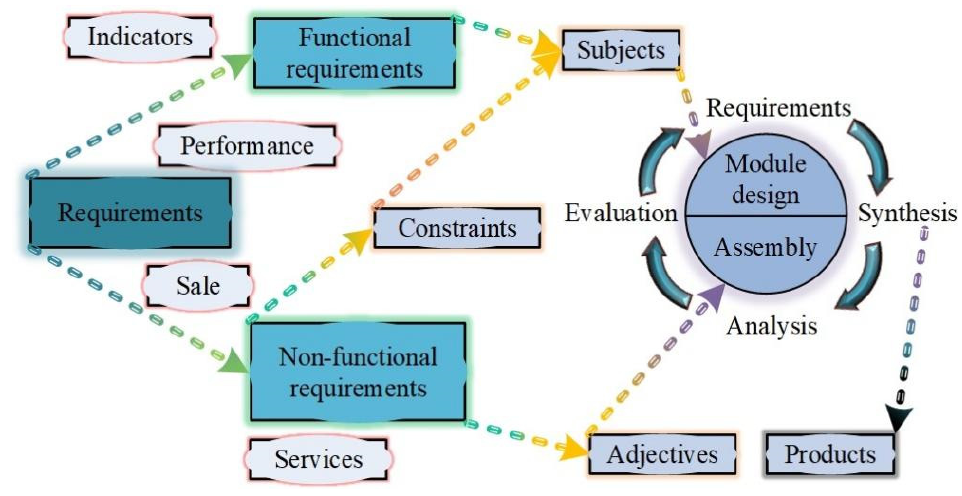
Figure 2. Design process of modular MPSs.